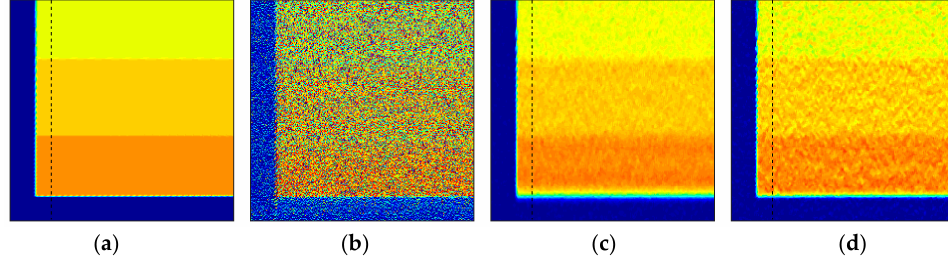
Figure 8. ( a ) Sharp image to be recovered, ( b ) result obtained using assumed P deconvolution without regularization, ( c ) polar restored image after nine iterations with five iterations of steepest descent, and ( d ) polar restored image after nine iterations with 15 iterations of steepest descent. Colors represent intensity. Dashed black line represents r/R = 0.95 used to plot profiles in Figures 9 and 10. Axes are the same as in Figure 7. Rotation is downward; images are in polar coordinates.